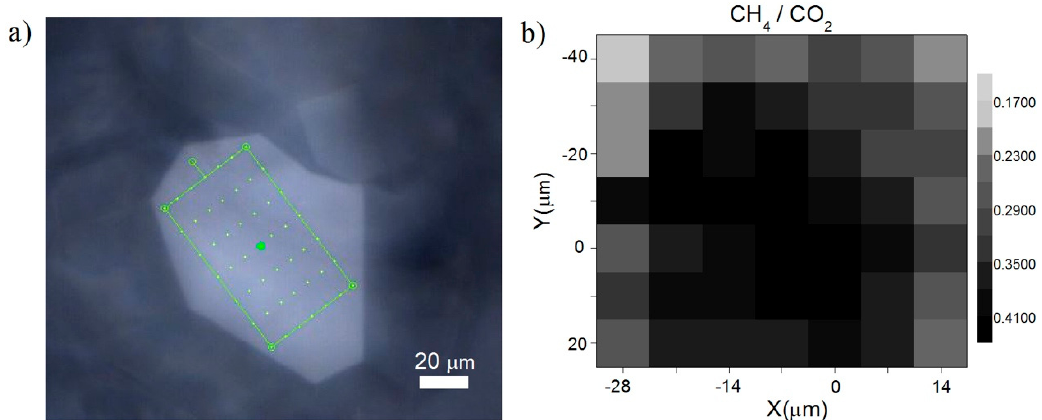
Figure8. ( a )Ramanmappingonahydratecrystalsurface. Atotalof49(7 ×